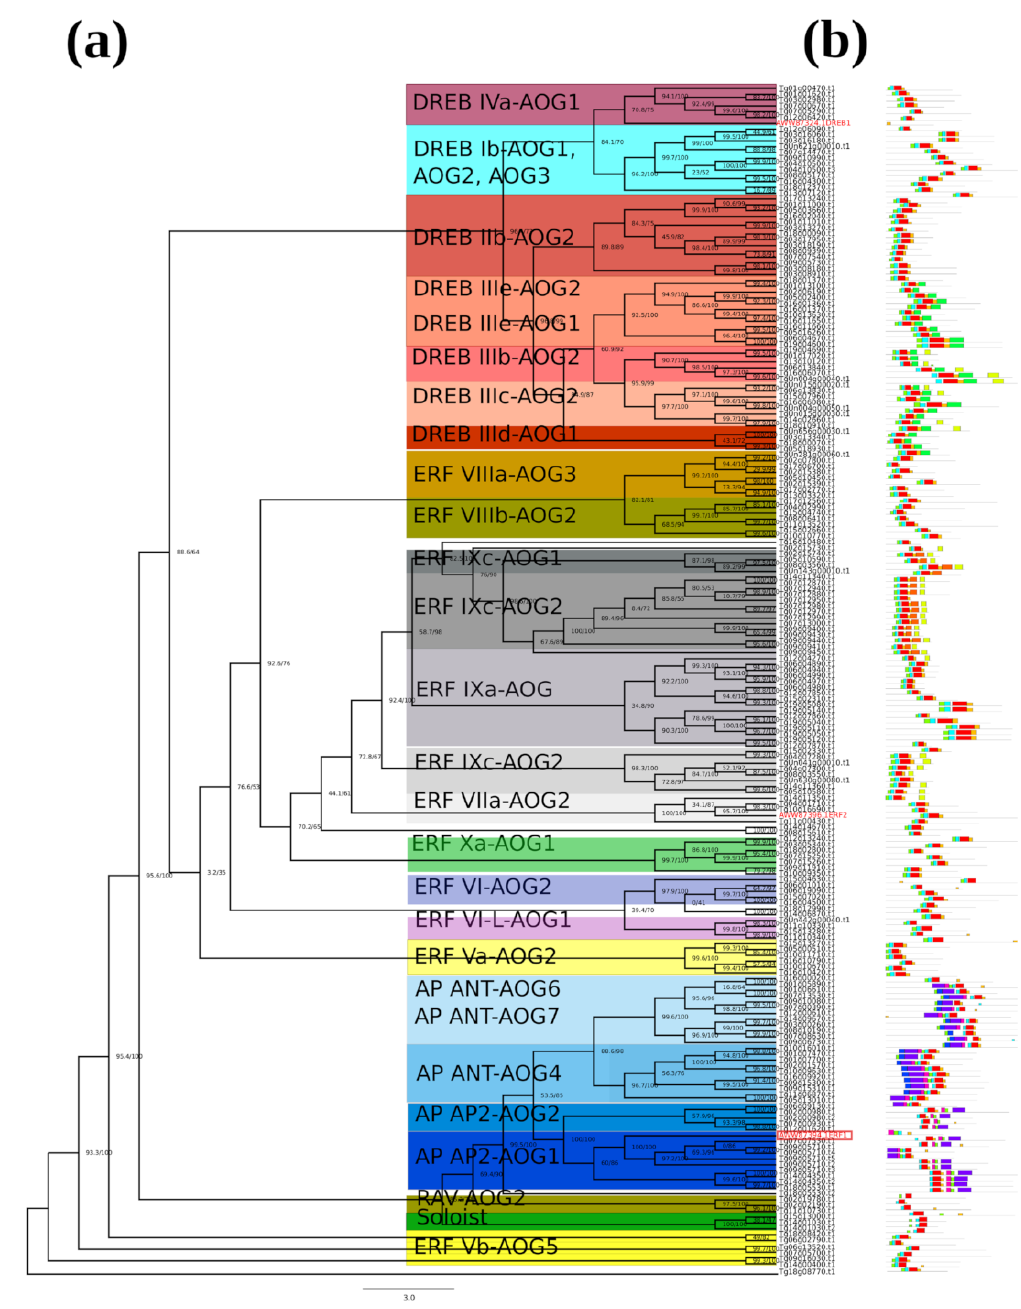
Figure 2. Phylogenetic tree and conserved protein motif for the teak AP2/ERF family of transcription factors. ( a ) The AWW87324, AWW87394, and AWW87396 proteins were aligned for construction of the phylogenetic tree. The consensus tree (after 1000 bootstrap samplings) with teak subgroup names is shown. The branch of AP2/ERF classification for teak is shown in blue, Arabidopsis in green, and rice in red. The scale bar indicates the substitution rate per residue. The motif composition of teak AP2/ERF proteins and the ten motifs are displayed in different colored boxes ( b